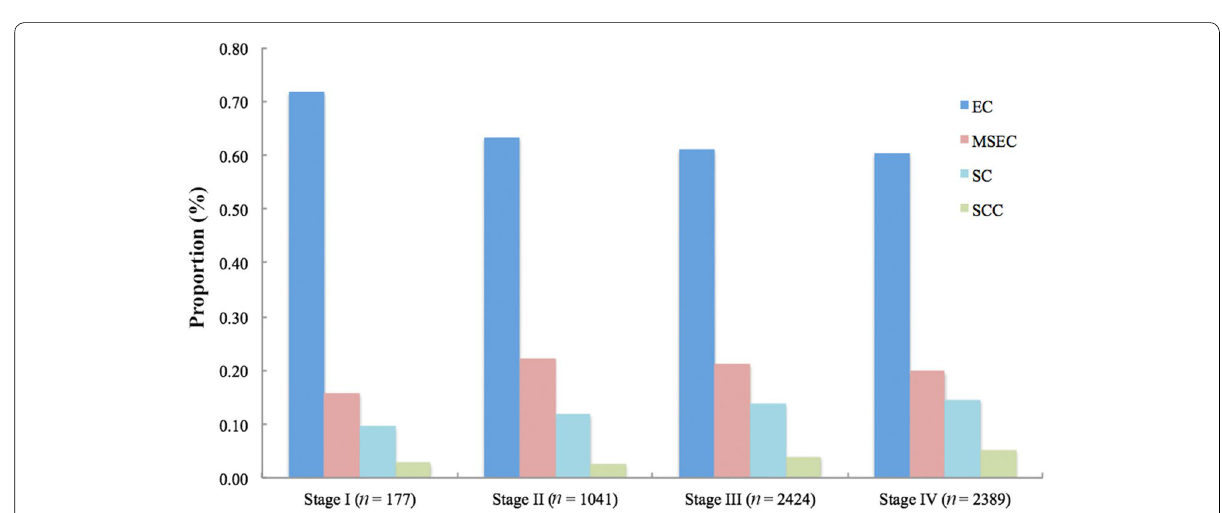
Fig. 5 Associations between clinical stage and the proposed histopathologic classification in all NPC patients. The proportions of EC cases are 71.8%, 63.3%, 61.1%, and 60.4% in patients with stages I, II, III, and IV NPC (the 1992 China and 1997 AJCC staging systems combined), respectively, whereas those of SC cases are 9.6%, 11.8%, 13.7%, and 14.6%, respectively. The proportion of SC increased with advanced stage, whereas the pro‑ portion of EC decreased with more advanced stage (Chi square test, P =